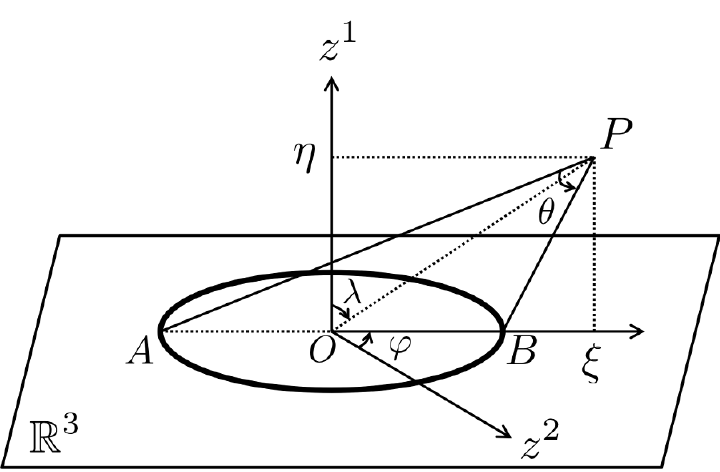
Figure 2 . Hypertoroidal coordinates ( (cid:26); (cid:18); ’; ! ): the region inside the circle drown by the heavy line stands for a three-ball of radius a embedded in R 3 . This three-ball plays a role analogous to a branch cut in a 2d Riemann space once we extend the interval of (cid:18)